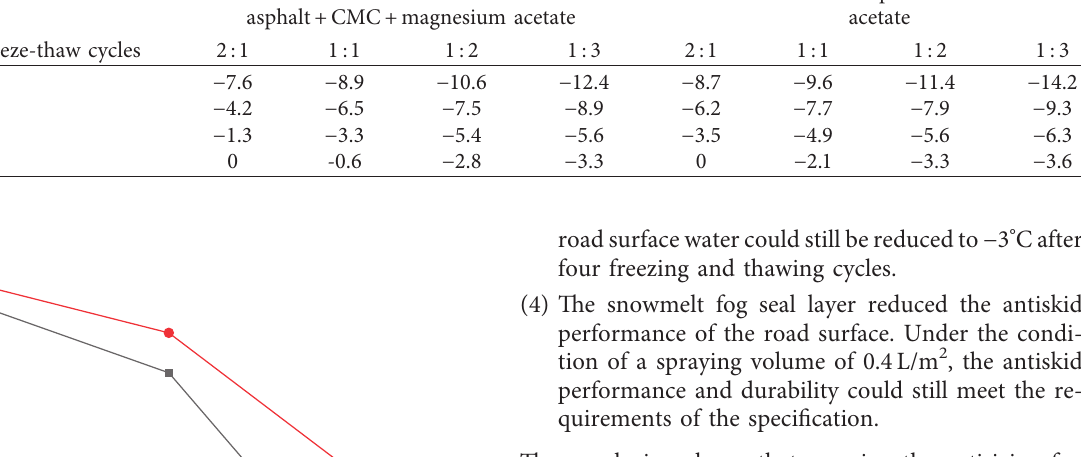
Table 8: Freezing point test results for the anticondensation ice fog seal layer against repeated freeze-thaw cycles ( ° C). Matching plan